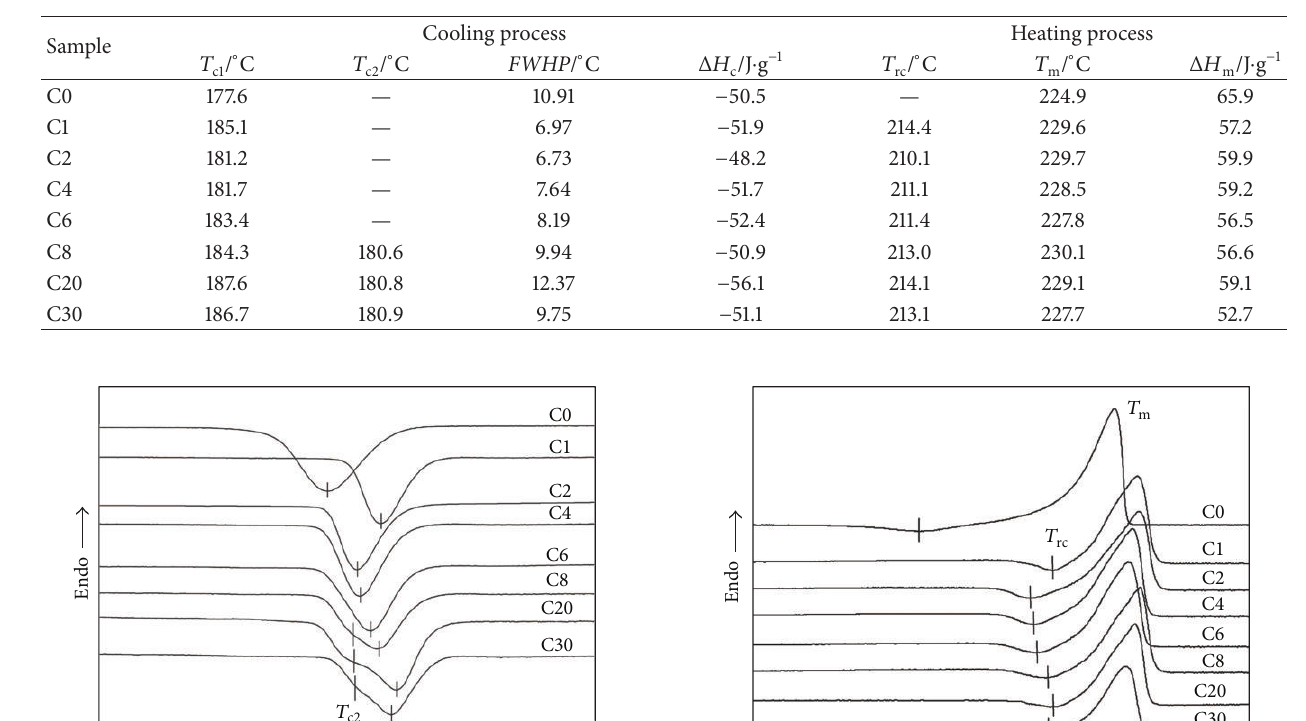
nanocomposites. 3